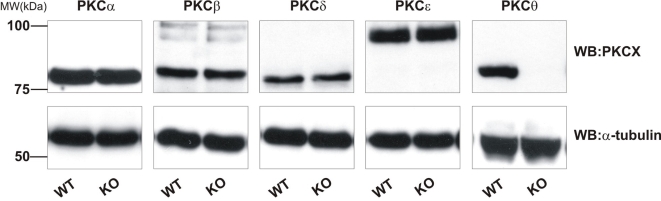
PKC isoforms are not upregulated in PKCθ−/− mice.Platelets lysates from wild-type (WT) or PKCθ−/− (KO) mice were assessed for PKC isoform expression by SDS-PAGE and western blotting using specific antibodies for PKCα, -β, -δ, -θ and -ε. Membranes were stripped and re-probed for α-tubulin as indicated to ensure equal loading of protein. Blots are representative of three independent experiments.